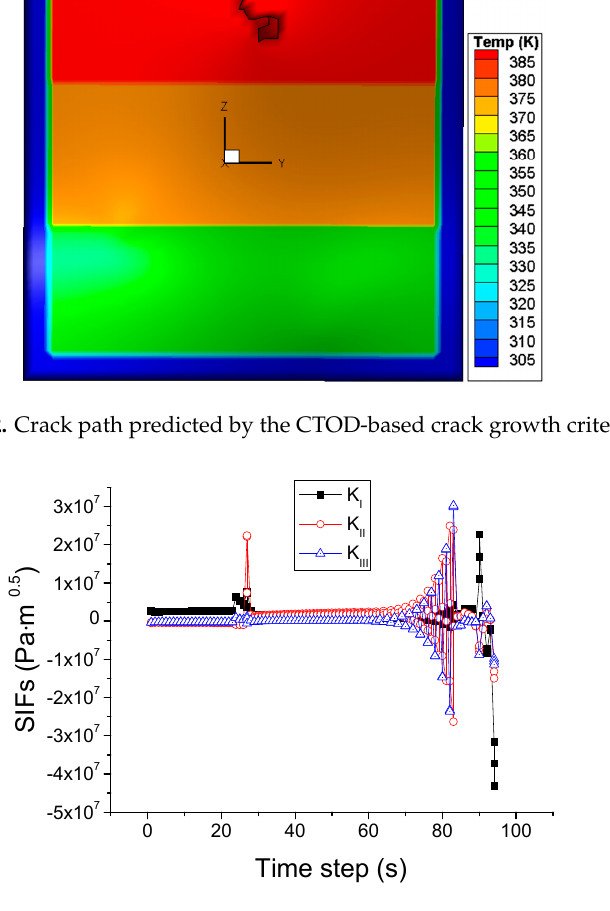
Figure 23. Variation of SIFs associated with the CTOD-based crack growth criterion.